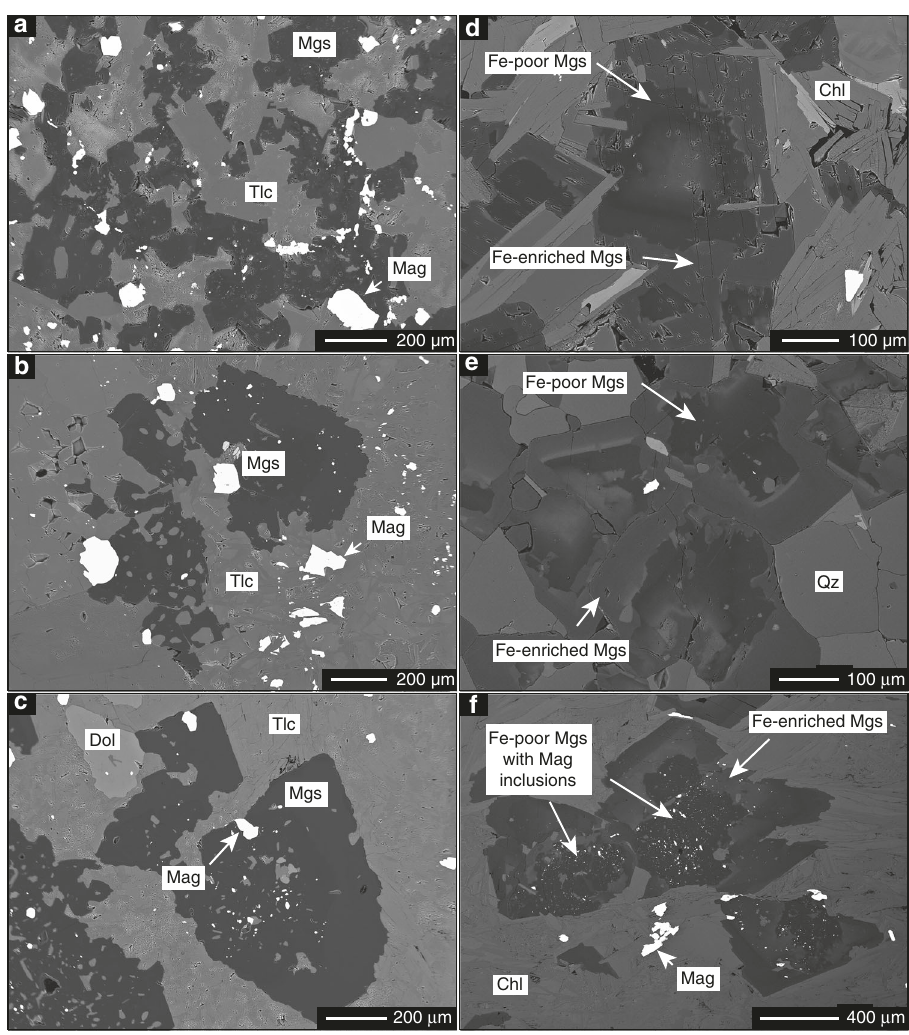
Fig. 4 Magnesite growth textures. Back-scattered electron (BSE) images showing magnesite textures in soapstone a – c and listvenite d – f . Anhedral to subhedral magnesite in the soapstone frequently contains magnetite inclusions, whereas euhedral magnesite rims related to listvenite formation are in most cases devoid of magnetite. The zonation of listvenite-magnesite is caused by elevated Fe/Mg in the euhedral representing each lithology at a sensor-to-sample distance of 170 µ m and with 85 µ m line spacing. At the same imaging resolution, we also performed anhysteretic remanent magnetization (ARM) fi eld measurements to assess the distribution of magnetic carriers within the samples at fi ne spatial scale. After full alternating- fi eld demagnetization of the samples, we imparted ARMs with a bias fi eld of 100 μΤ and a peak alternating fi eld of 260 mT to activate the capacity of the sample to acquire magnetization.